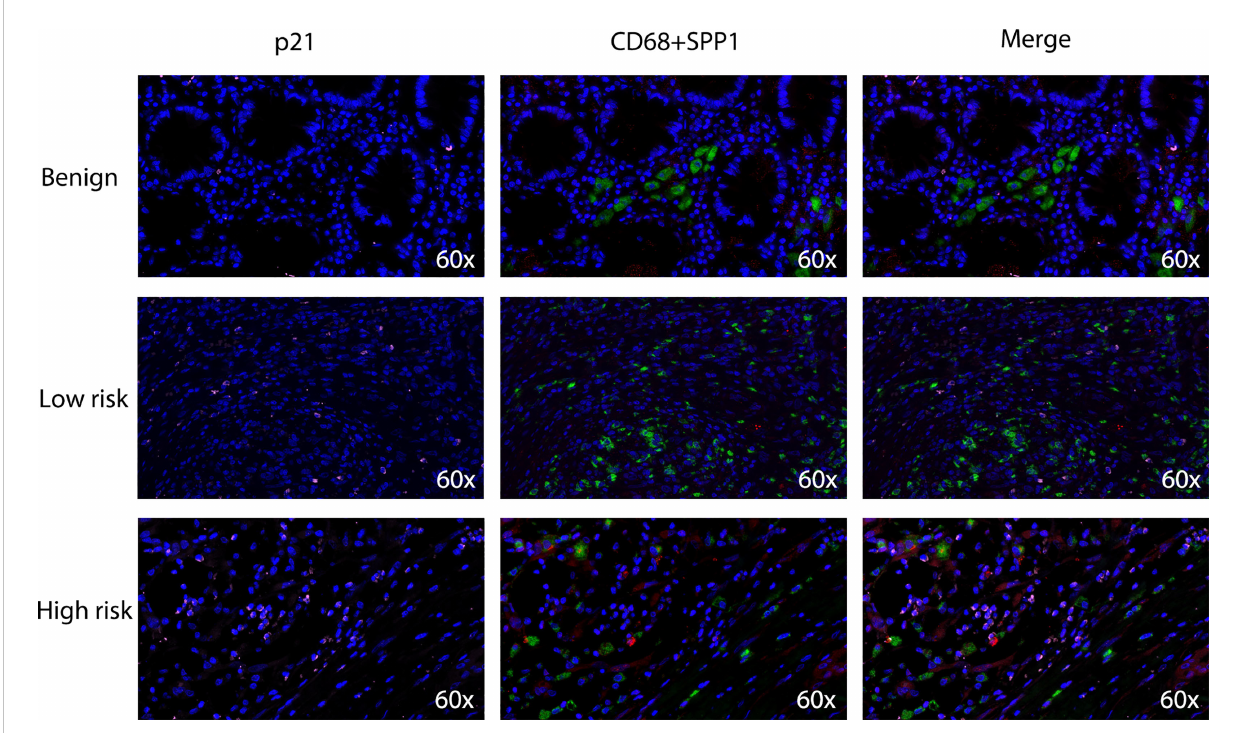
FIGURE 7 Densities of tumor-in fi ltrating SPP1 + /CD68 + macrophages and p21 + senescent cells in benign colon tissues, low-grade colon tumor tissues and high-grade colon tumor tissues. Confocal microscopy scan of immuno fl uorescence staining showed the distribution of SPP1 (red) positive CD68 (green) double positive macrophages and p21 (pink) positive senescent